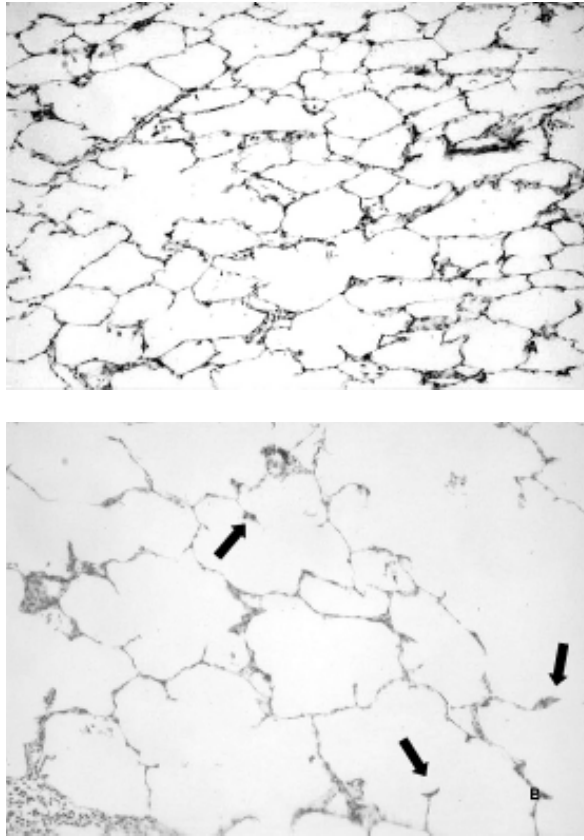
Fig. 3 – Fotomicrografias de parênquima pulmonar de ratos submetidos à instilação de solução fisiológica (A) ou papaína (B). Setas sinalizando a formação de “baquetas”. Coloração HE. Aumento de 100X.